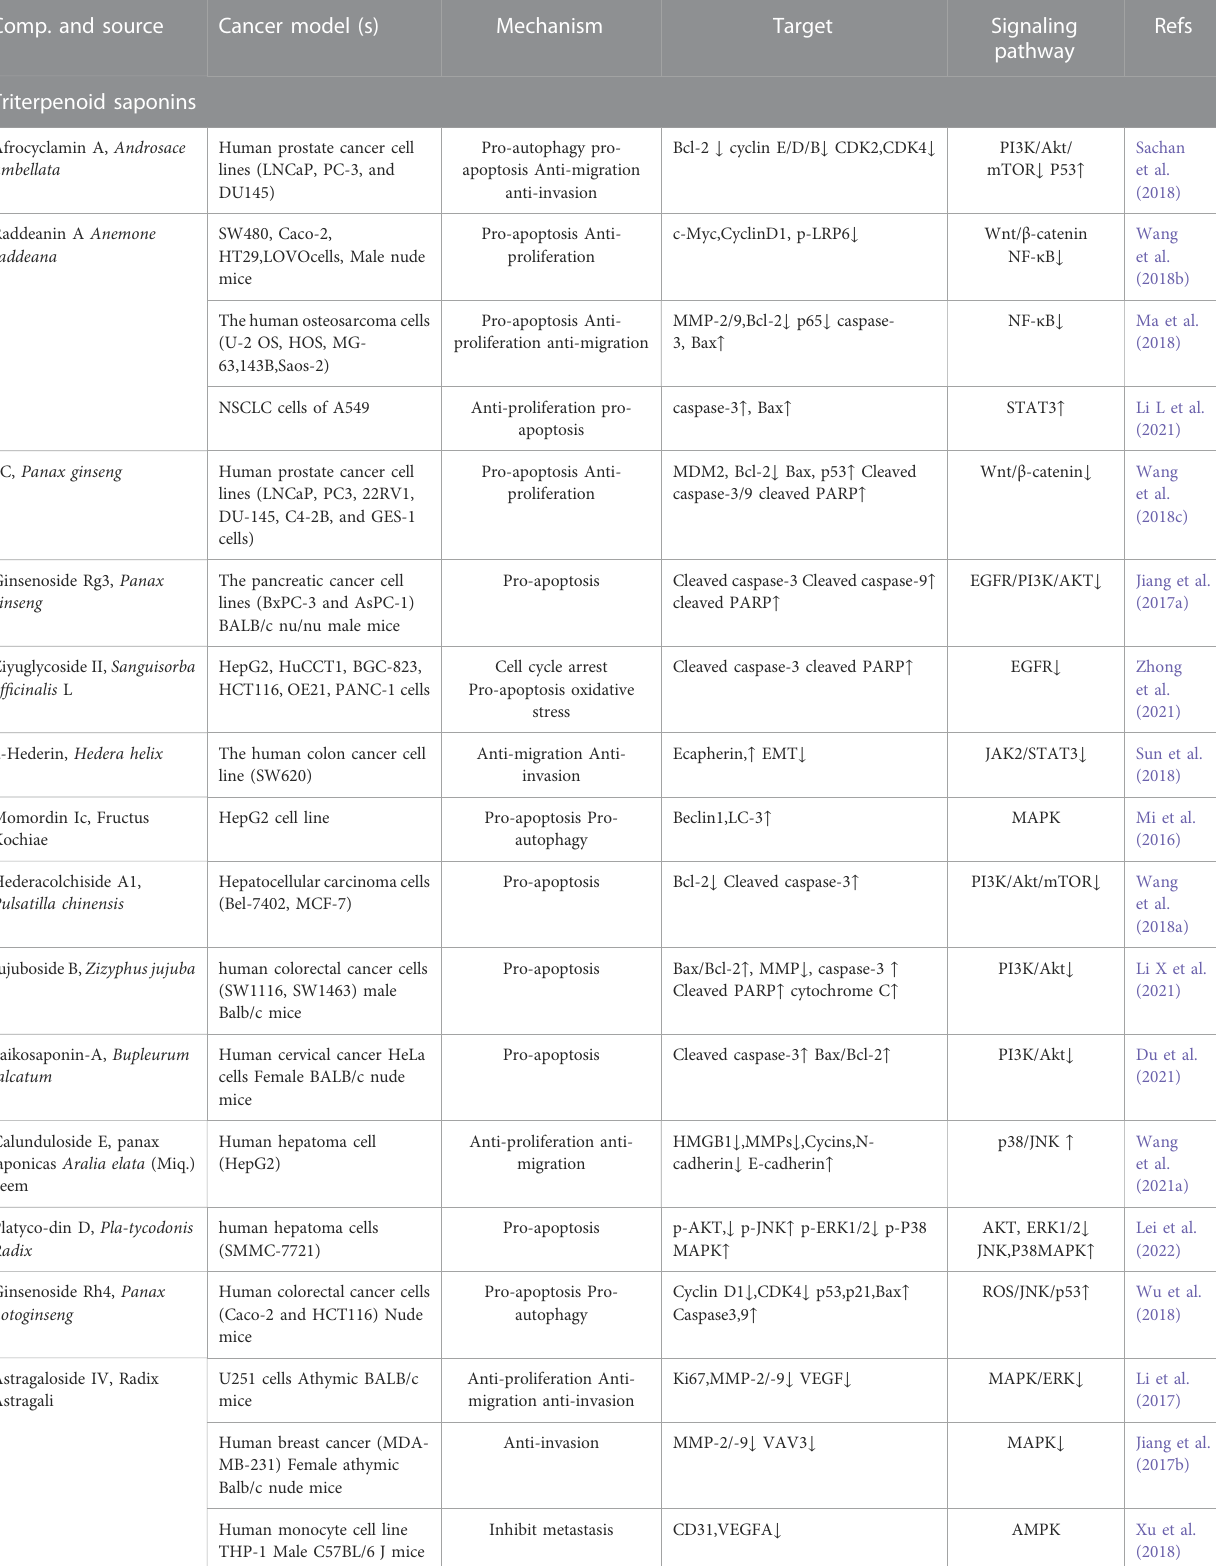
TABLE 1 Monomer saponins against cerebral ischemia-reperfusion injury. Up arrows indicate upregulation, while the down arrows indicate downregulation. Comp. and